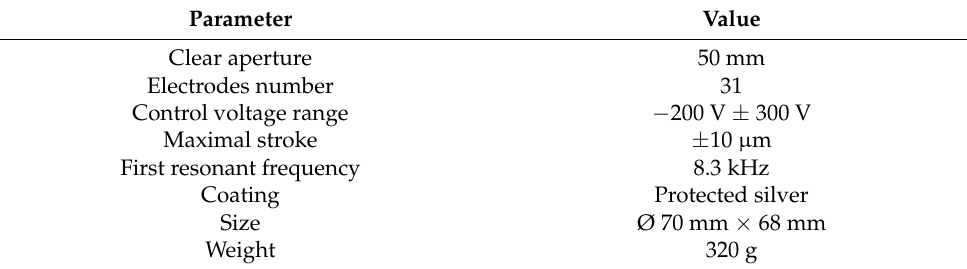
Table 1. Main parameters of the bimorph mirror.